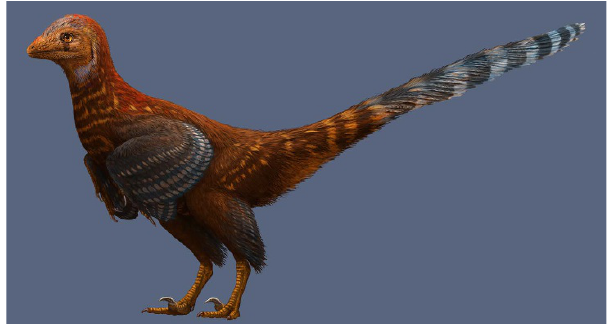
Figure 7 | Life reconstruction of Jianianhualong tengi . Life reconstruction of Jianianhualong tengi by Julius T. Csotonyi based on the holotype